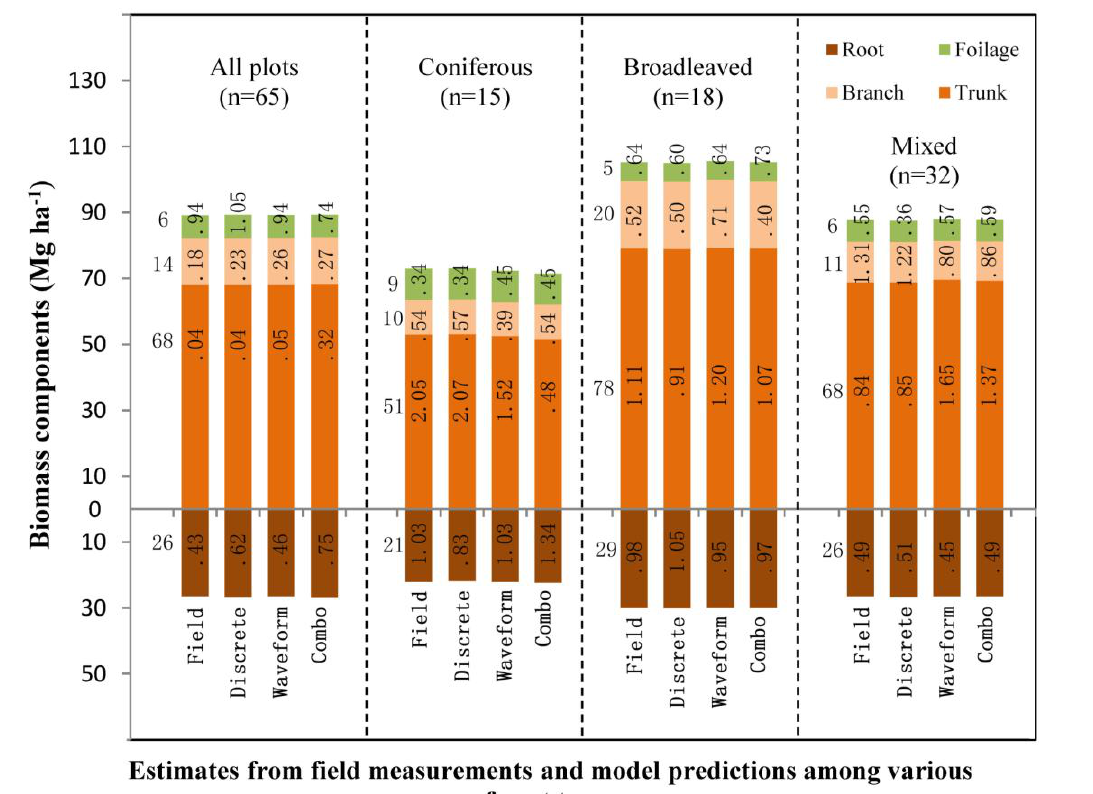
Figure 8. Relationship between plot-level field measured and LiDAR-estimated biomass components of three sets of models ( i.e. , discrete data based model, full-waveform based model and the combo model) within each type of forest. Each biomass components are calculated as the average value of the plots within specific forest